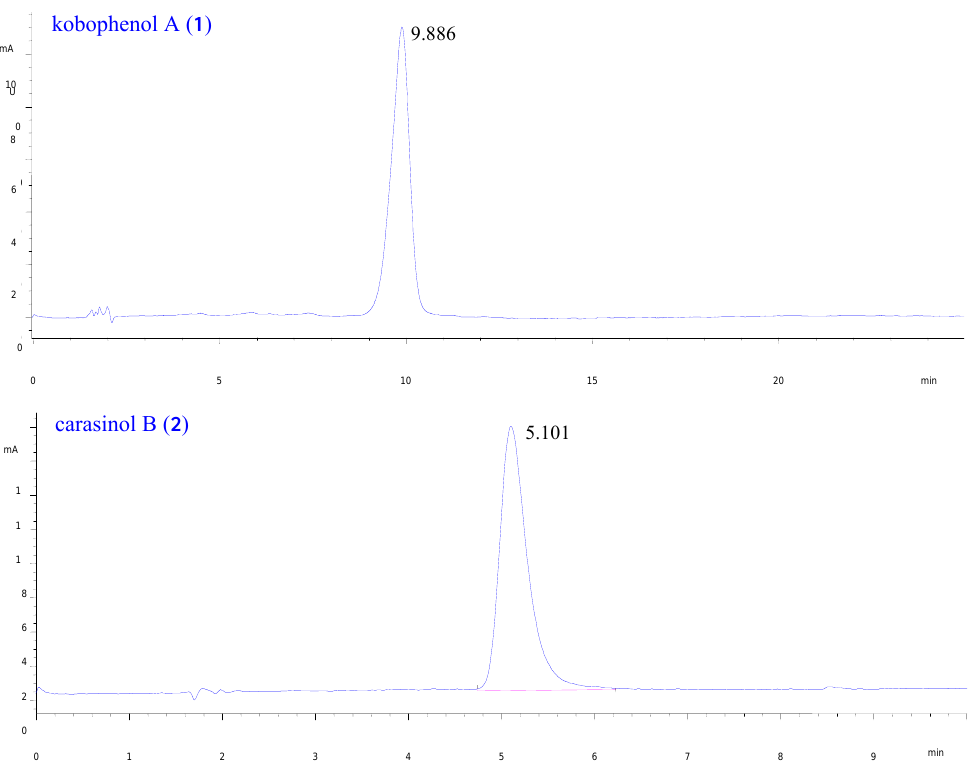
Figure 3 . HPLC Chromatograms of 1 and 2